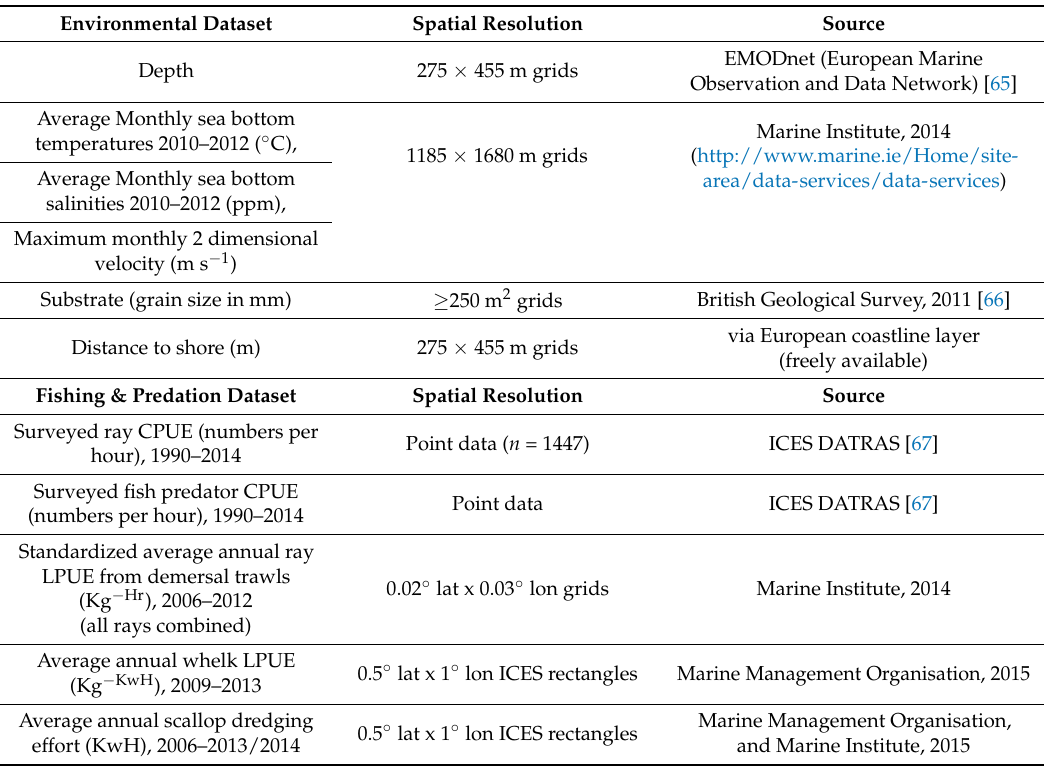
Table 3. Datasets used during modeling, and their sources. CPUE/LPUE: catch/landings per unit